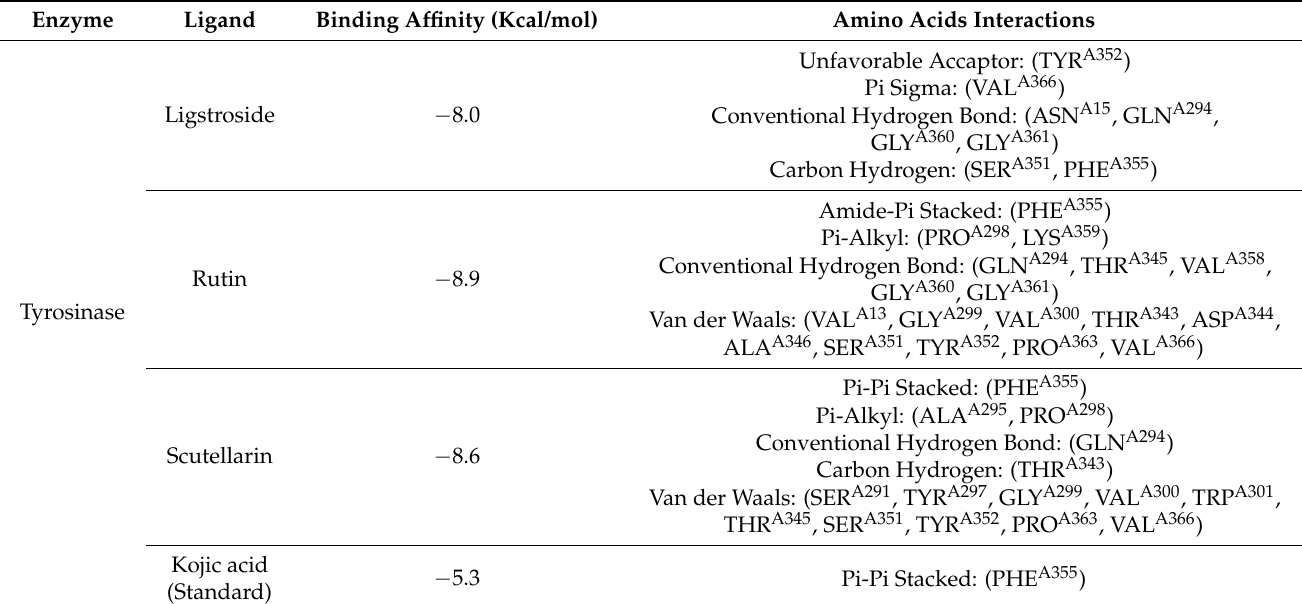
Figure 6. Molecular docking of selected ligands with tyrosinase enzyme. ( A ) Ligstroside, ( B ) Rutin, ( C ) Scutellarin, and ( D ) Kojic acid. Table 8. Binding affinities and interactions of the selected ligands from S. glutinosus extract by LC-ESI-MS against tyrosinase